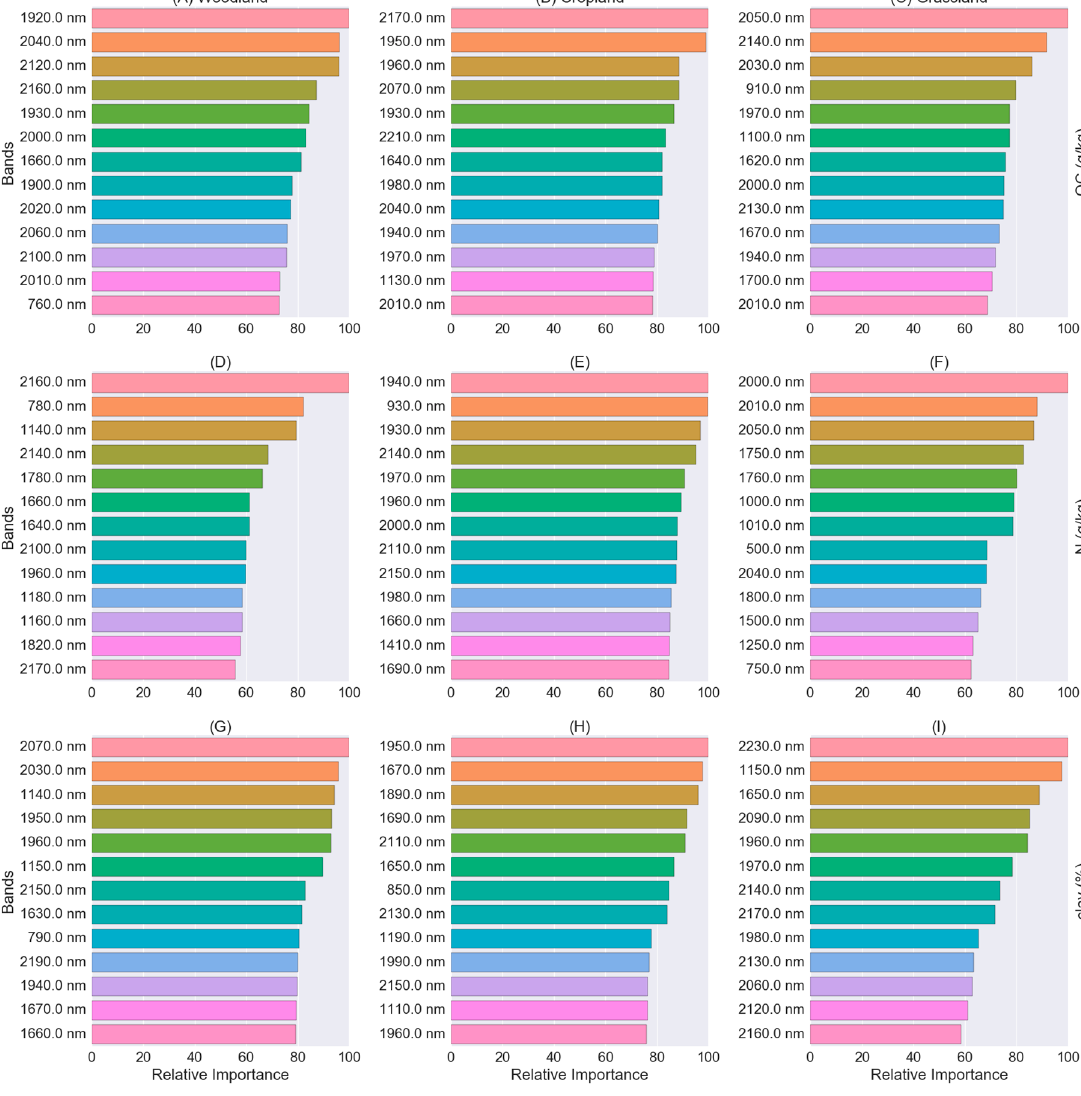
Figure 8. The top 13 relative important variables derived from PLS regression models. ( A – C ) are relative important variables derived from OC models for woodland, cropland, and grassland soils, and ( D – F ) are relative important variables derived from N models, and ( G – I ) are relative important variables derived from clay models.